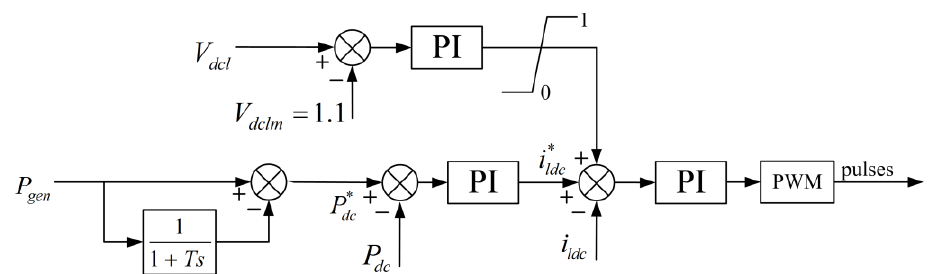
Figure 7. Control strategy of the DC/DC